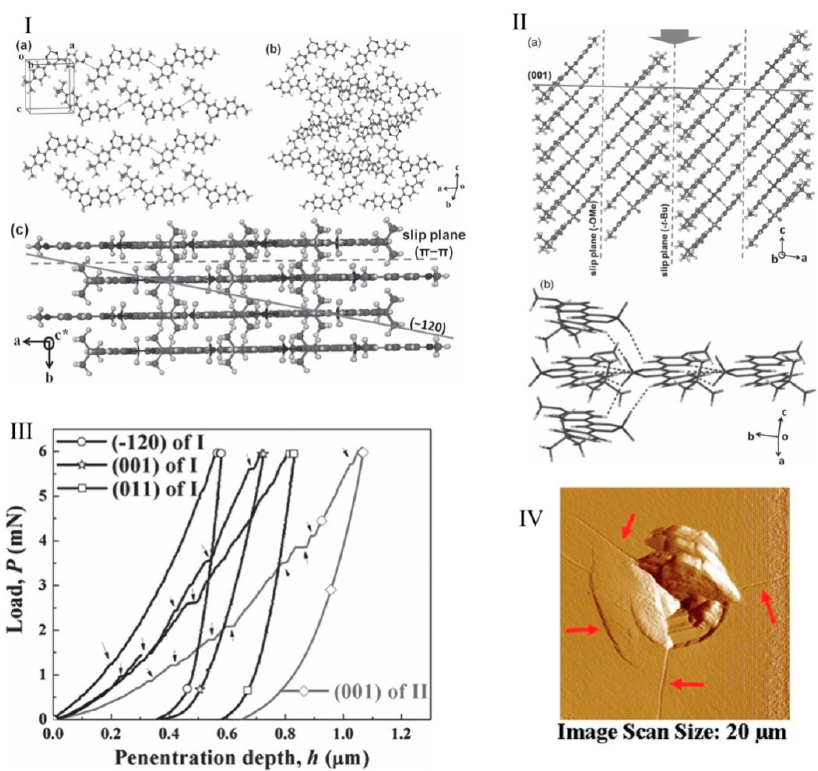
Figure 11. Crystal packing of the BF 2 AVB, I ( a – c ). Green form (brittle), II ( a – c ). Cyan form, III . Representative P-h curves obtained from various faces ((011), (001), and (120)) of the green polymorph crystals and the (001) plane of the cyan polymorph. IV : The post-indent AFM image of the (120) face of the green polymorph shows cracks along the indenter corners. (Reproduced with permission from Wiley VCH, Reference 91).